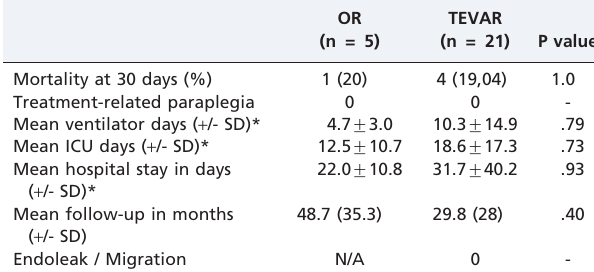
Table 1 - Preoperative comorbidity and variables on admission.